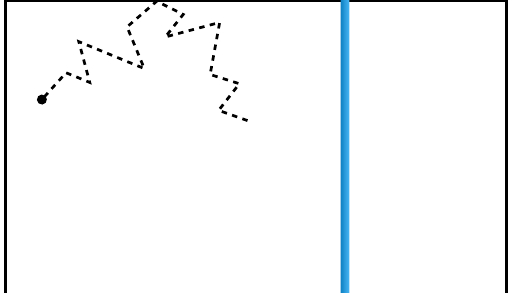
FIG. 1. A two-dimensional Szilard box with a single Brownian particle, where a vertical partition (blue) can be positioned at different horizontal locations in the box. We demonstrate that only information about the particle ’ s horizontal position, not its vertical position, can be used to extract work from the